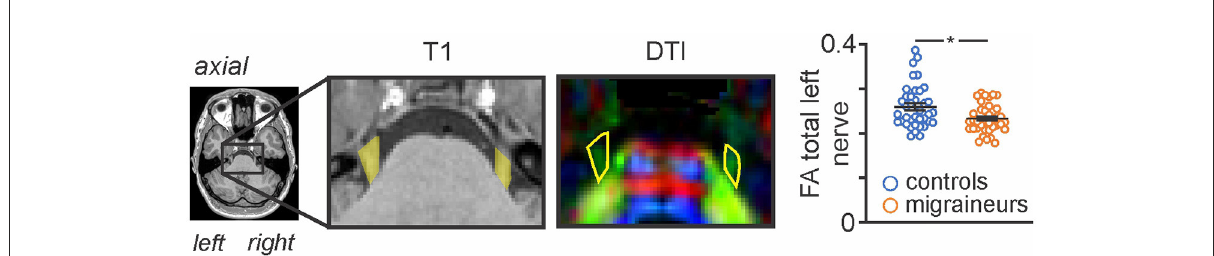
FIGURE1 Axial T1-weighted anatomical image and corresponding diffusion tensor (DTI) image showing the trigeminal nerve root entry zone in a single participant. The DTI image is color-coded for direction of greatest water movement. The outline of the trigeminal nerve region used for the total nerve analysis is shown in yellow shading on the T1-weighted anatomical image and is also outlined in yellow on the DTI images. This volume of interest encompassing the root entry zone is the section of the trigeminal nerve that lies within the pontine cistern, i.e., from where it emerges from the pons, to the point at which it exits the pontine cistern anteriorly. Plots of FA left nerve values for individual controls and migraineurs are shown in the right inset. Horizontal bars indicate mean ( ± SEM) in the control and migraine